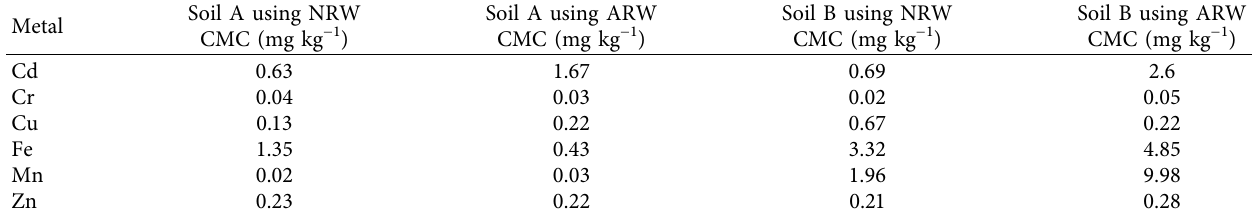
Table 2: Cumulative metal concentration (CMC) released from soils A and B under natural and simulated rainfall